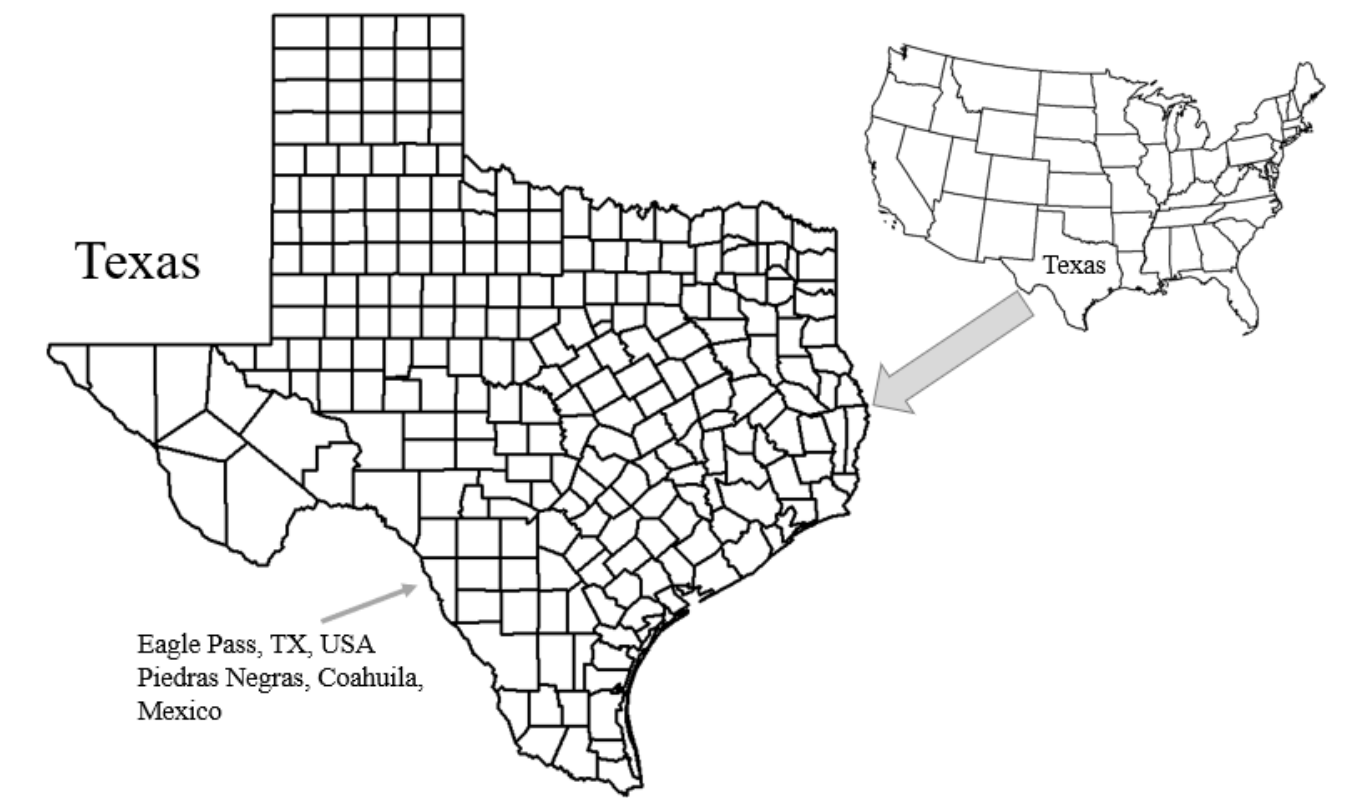
Figure 10. Location of Eagle Pass, Maverick Co., Texas, USA, and Peidras Negras, Coahuila, Mexico.